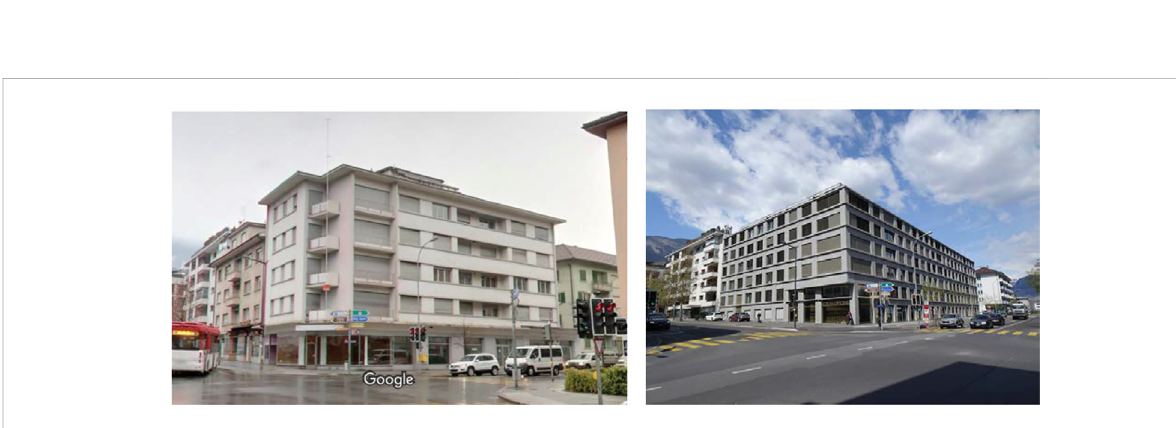
FIGURE 9 Sion, three URM and RC buildings demolished and replaced by a single large mid-rise RC. building with a “ U ” plan